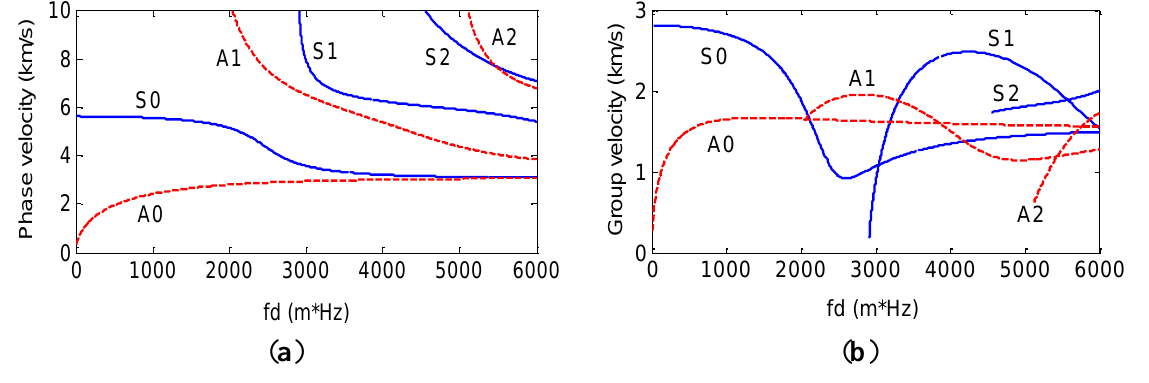
Figure 2. The ULW frequency dispersion curves of ( a ) c aluminum